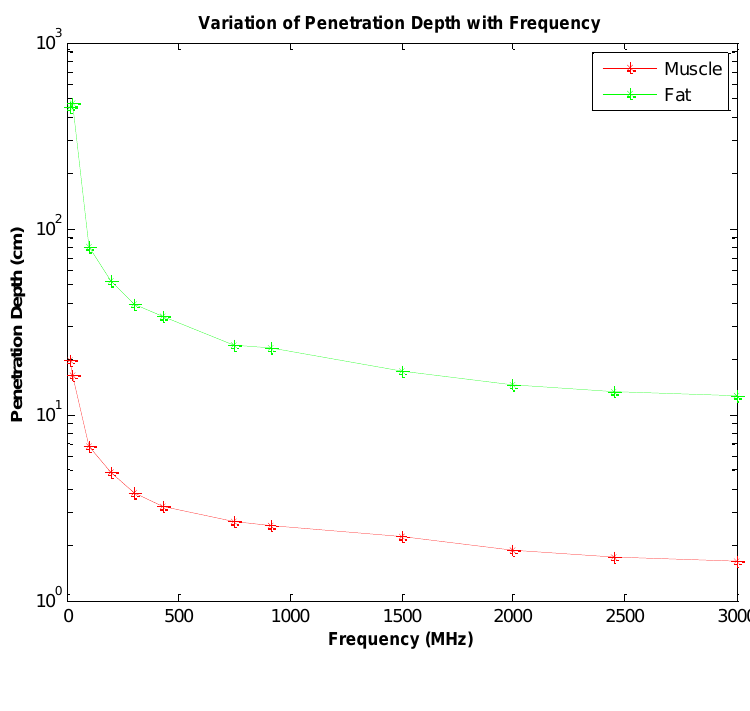
Figure 2. Variation of Penetration depth with